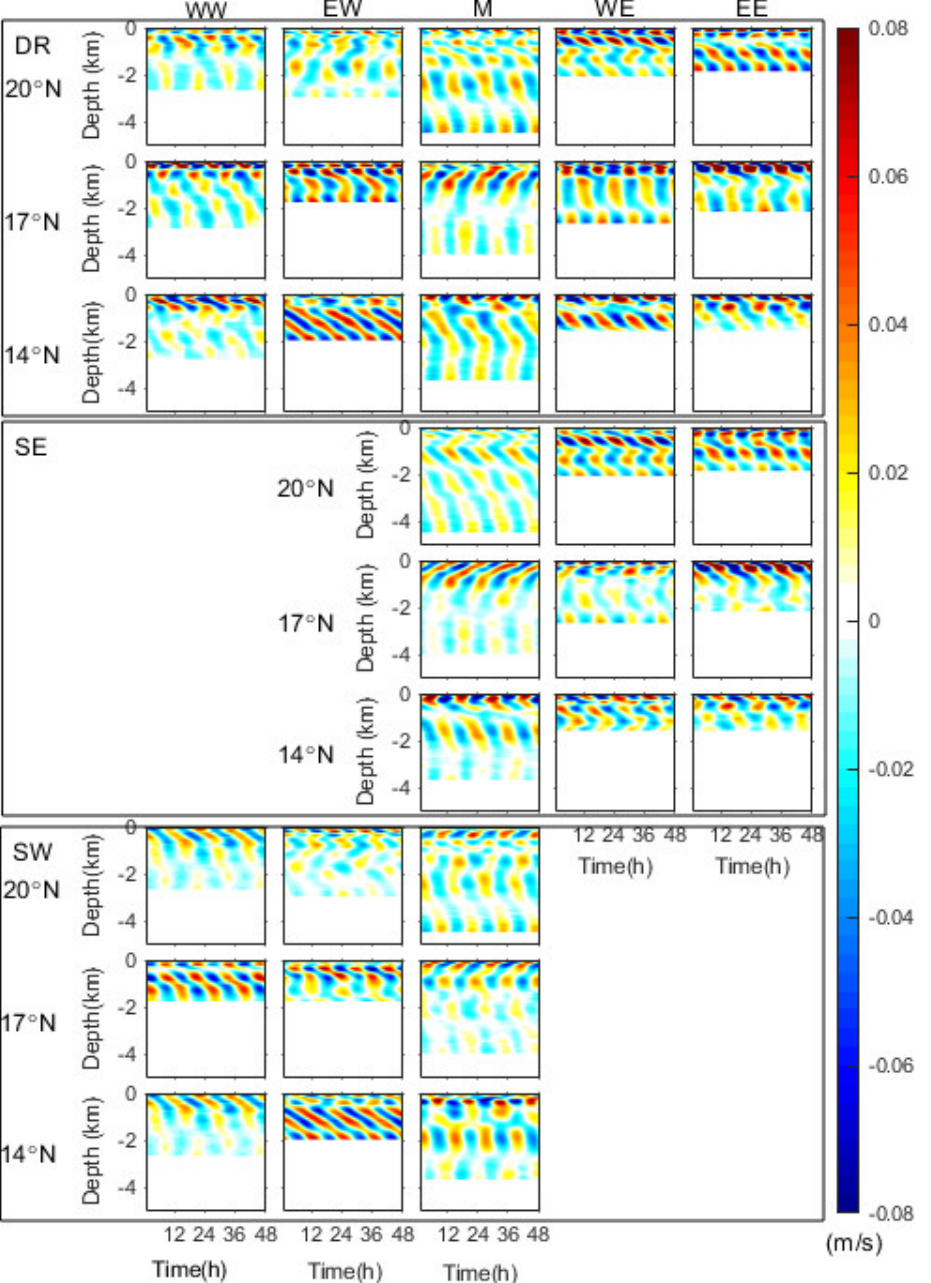
Figure 9. Temporal variations of M 2 internal tide zonal velocity (m/s) at selected stations under DR ( upper box ), SE ( middle box ), and SW ( lower box ) cases from surface to bottom.